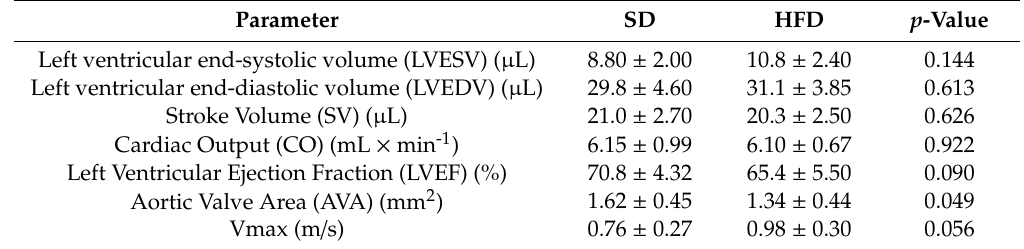
Table 1. Echocardiographic measurements in C57BL / 6 mice fed a standard (SD) or high-fat diet (HFD). Parameter SD HFD p -Value Left ventricular end-systolic volume (LVESV) ( µ